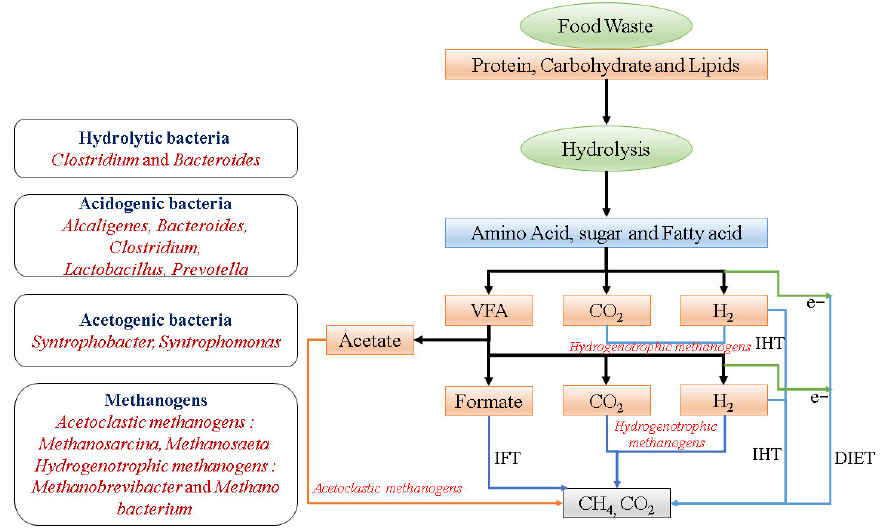
Figure 2. Mechanism of interspecies electron transfer in the anaerobic digestion process.